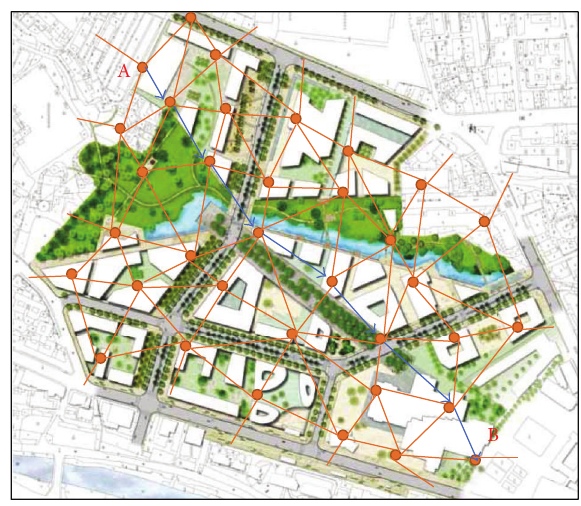
Figure 12: Information transmission line